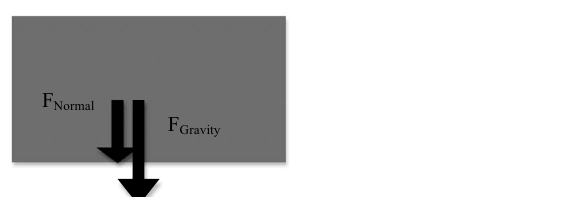
The regreased block of mass .40 kg, released from rest from point C, slides down the track and around the loop-the-loop of radius R = 0.15 meters. A. Draw a free-body diagram showing the forces acting on the block at point D, the top of the loop-the-loop. Hint: The block is pressed against the track.